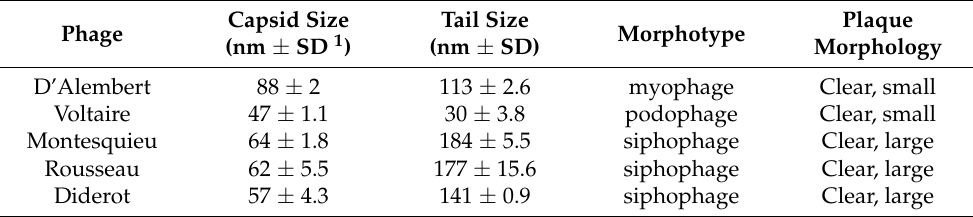
Table 3. Morphologic characteristics of the isolated